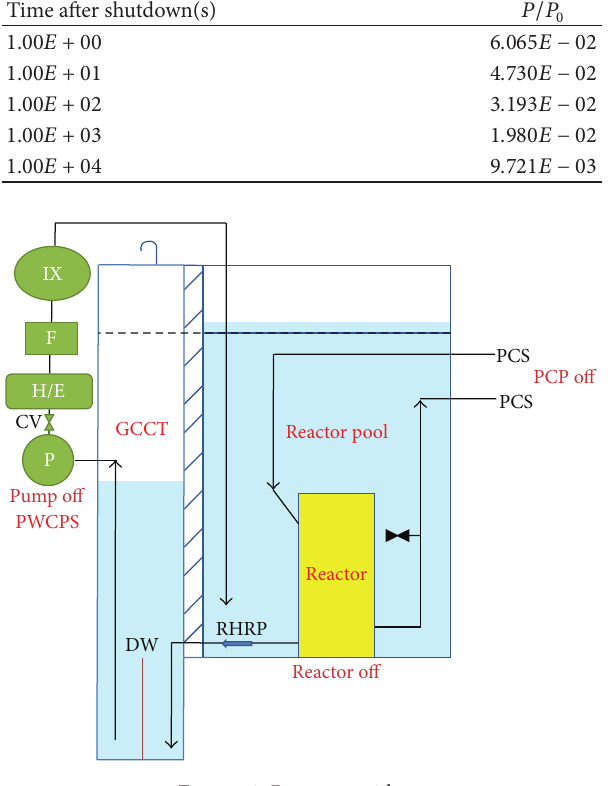
Figure 9: Reactor